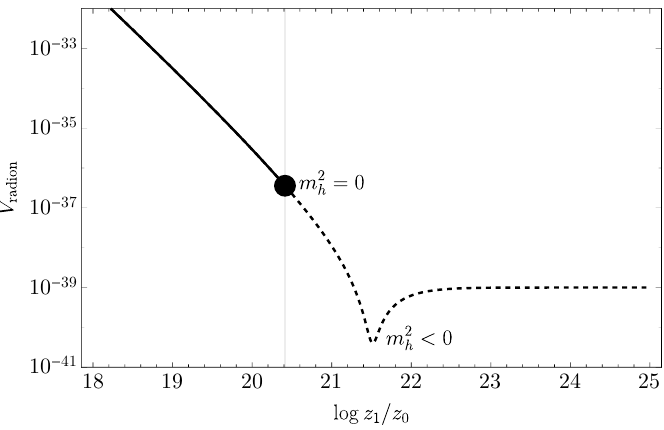
Figure 10. Here we show the radion potential. The dashed line is the potential if the Higgs VEV is left vanishing. There is a minimum of this potential where the metric ansatz for the IR brane is satis(cid:12)ed, but it corresponds to an unstable Higgs con(cid:12)guration. The solid line is the region where the e(cid:11)ective Higgs mass squared in the low energy theory is positive. At the dot, the mass vanishes, and if v 2 < v 2 (crit), the potential of the radion is minimized if the unstable Higgs region H H is forbidden. The gravity sector is not extremized here | the metric junction condition on the IR brane is not